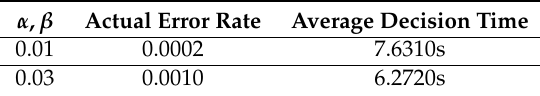
Table 4. Simulation results of HSTC (kinematic +